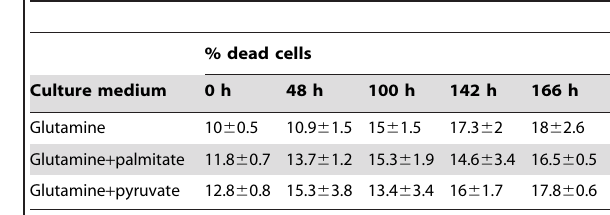
Table 1. Palmitate-induced death protection in two other CI- deficient human fibroblasts.